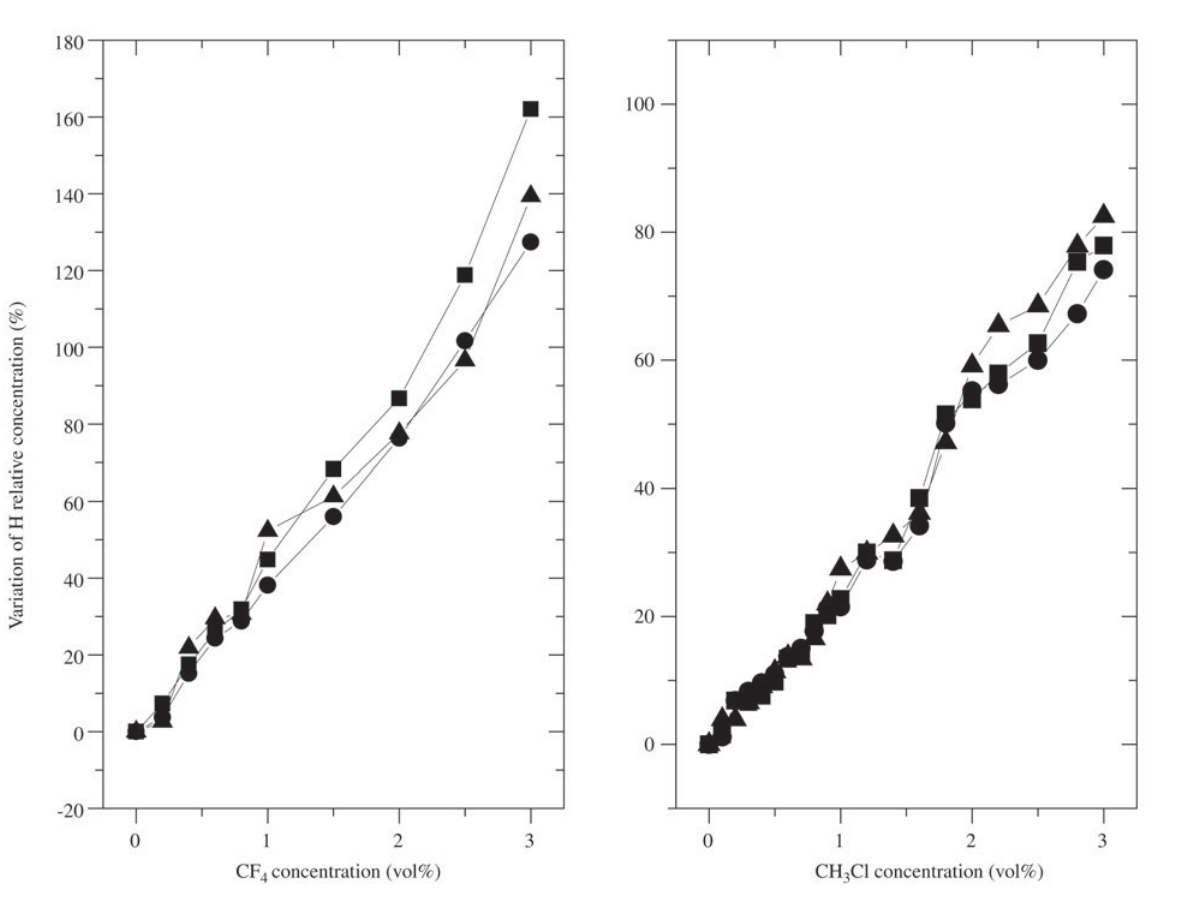
Figure 1. Variation of atomic hydrogen relative concentration with the halogen concentration. a) CF